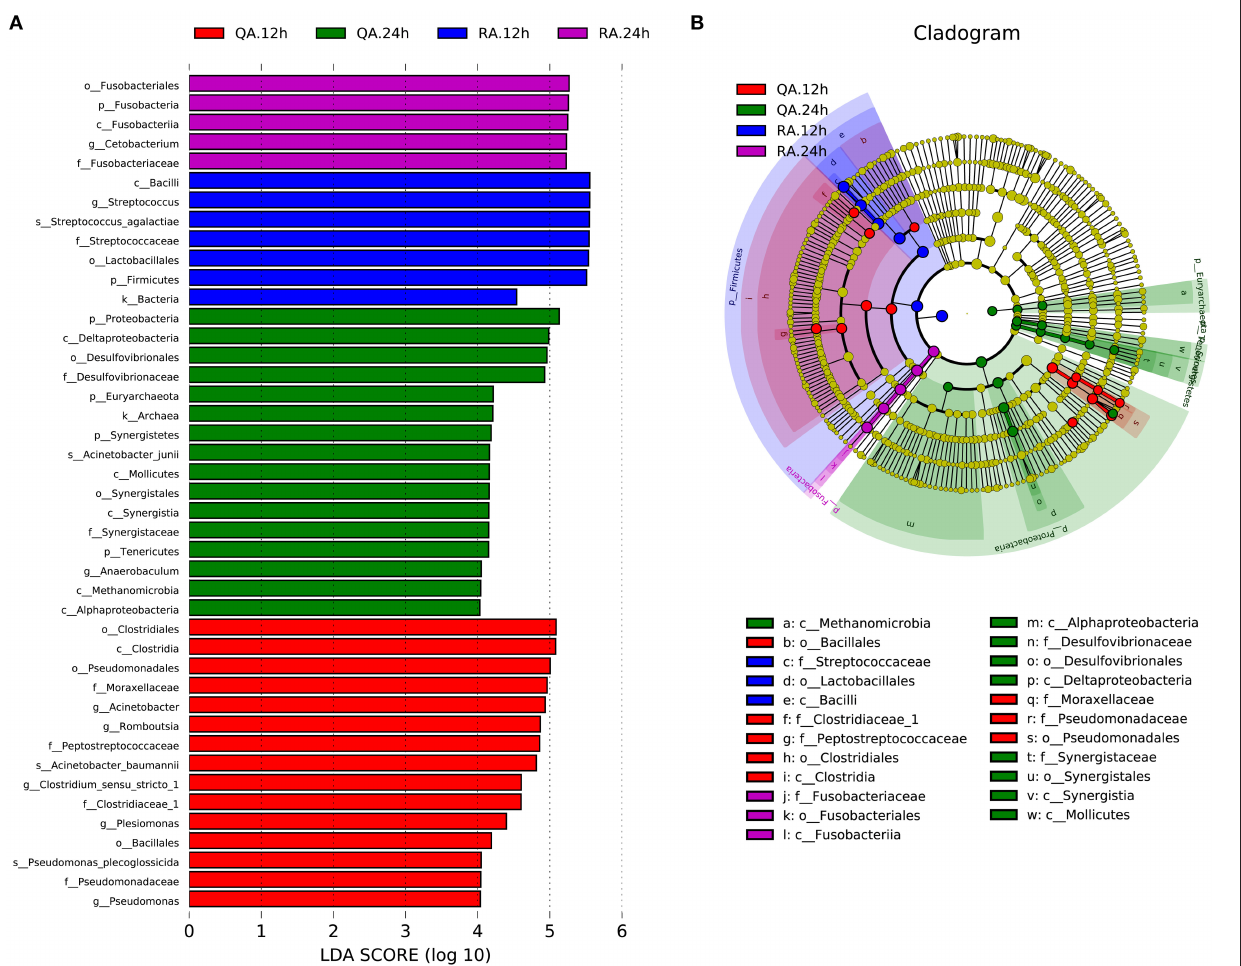
FIGURE 7 | YM001 and HN016 alter the intestinal flora composition differently. (A) The taxa whose abundance differed between the RA samples (blue and violet bars) and QA samples (red and green bars). The cutoff value of ≥ 4.0 used for the linear discriminant analysis (LDA) is shown. (B) Taxonomic cladogram obtained from LEfSe sequence analysis (relative bundance ≥ 0.5%). Biomarker taxa are highlighted by colored circles and shaded areas (RA samples are shown in blue or violet and QA are shown in red or green). Each circles diameter reflects the abundance of that taxa in the